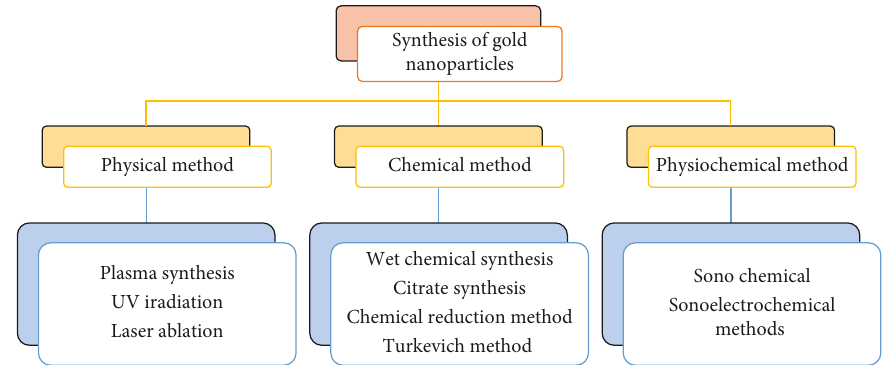
Figure 1: Synthetic methods for the synthesis of gold nanoparticles.